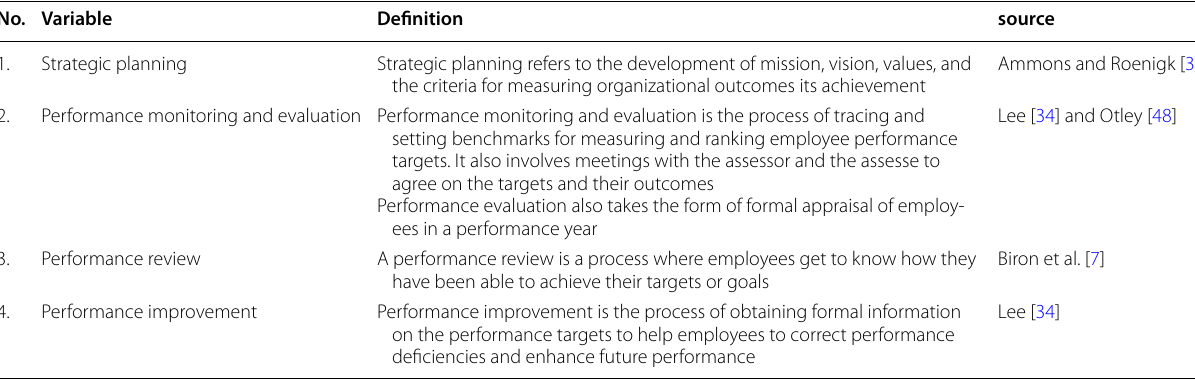
Table 1 Summary of the dimensions of PM No.